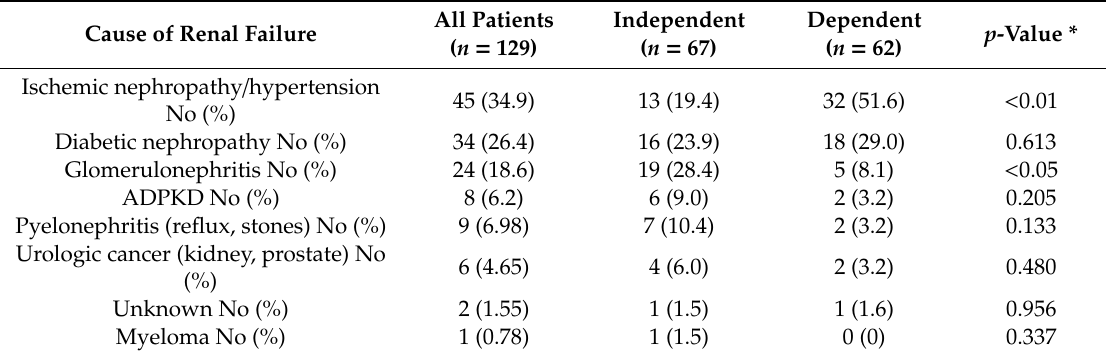
Table 2. Causes of renal